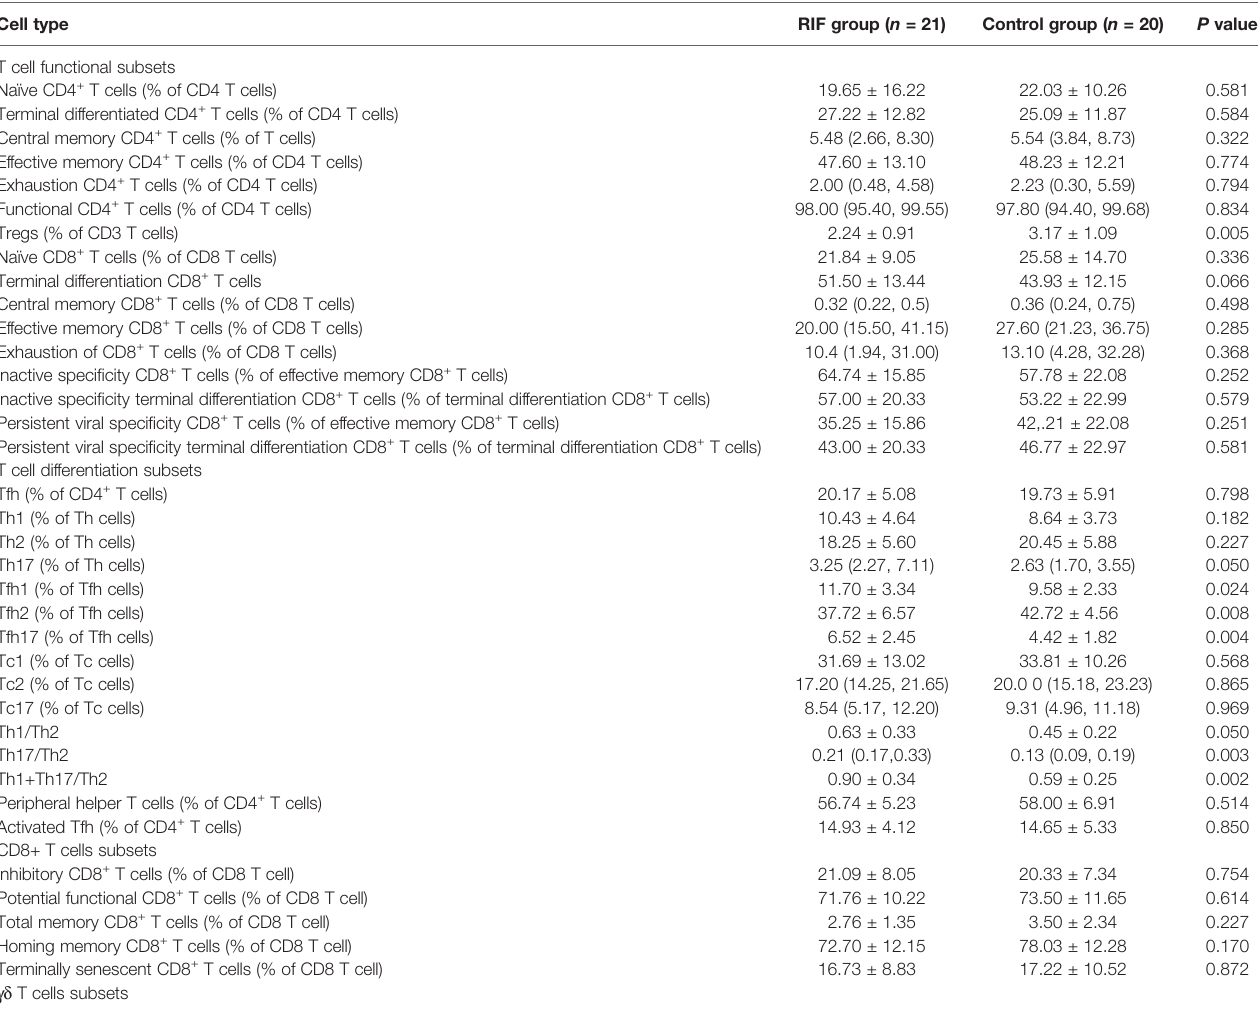
TABLE 3 | Comparisons of functions and differentiation of T cell subsets between the recurrent implantation failure and control groups in peripheral blood